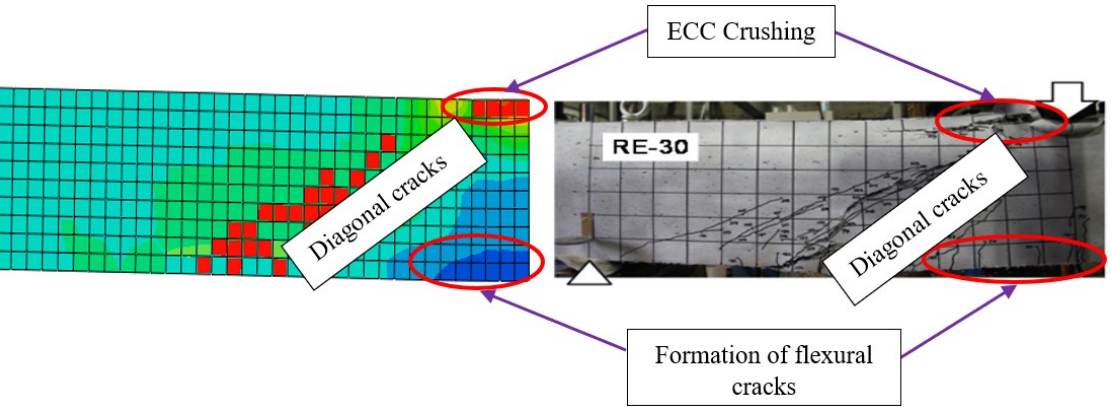
Figure 10. Comparison for component P4: the FE simulation’s plastic strain distribution and the experiment’s crack pattern were used.